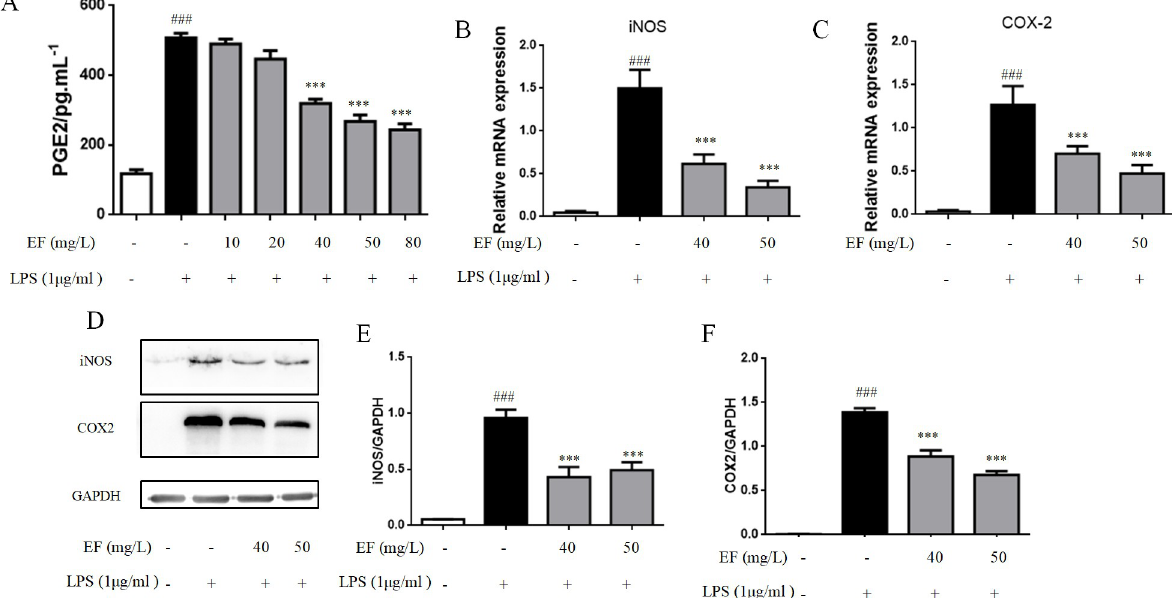
Fig 2. EF abrogated LPS stimulated production of PGE2 and inhibited the mRNA and protein levels of iNOS and COX-2. A: cells were treated with LPS (1 μ g/ml) and then added EF (10, 20, 40, 50, 80 mg/L). PGE2 levels were analyzed by ELISA. B/C: The mRNA levels of iNOS and COX-2 were determined by quantitative real-time PCR. D/E/F: The protein level of iNOS and COX-2 was determined by Western blotting analysis using specific antibodies. All data are shown as mean ± SEM (n = 6, per group) ##P < 0.01 vs control; �� P < 0.01 vs LPS.